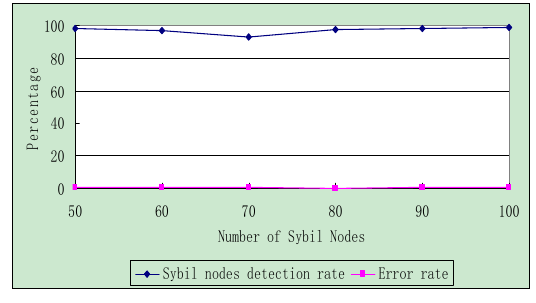
Fig.4. Detection